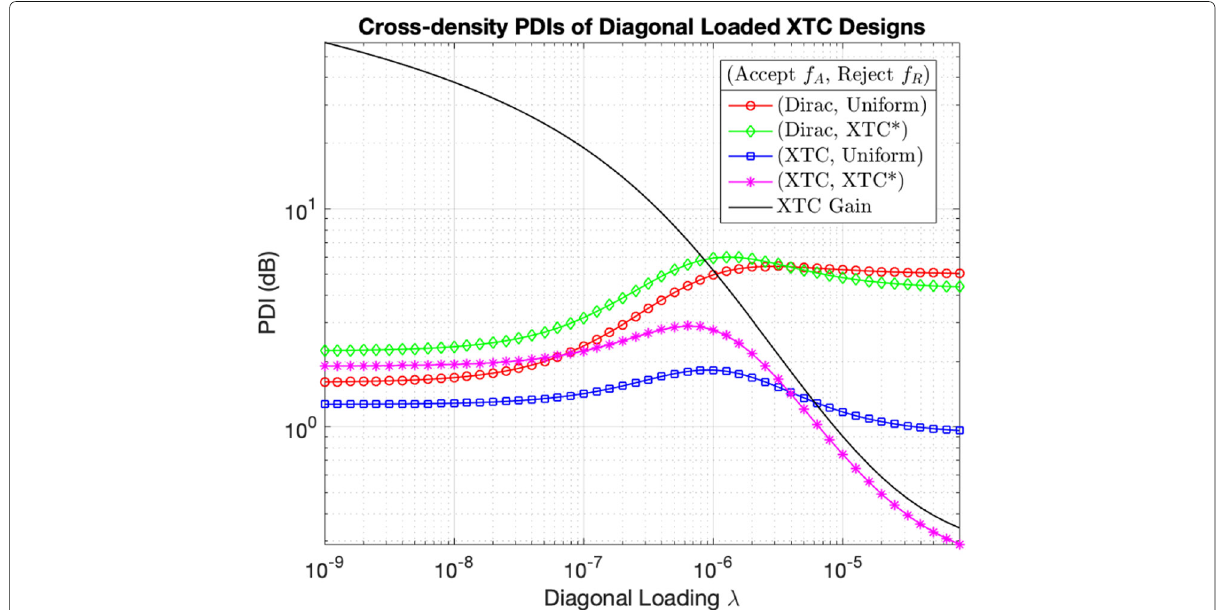
Fig. 6 Constant parameter λ regularized beamformers [7] parameterized by Eq. 47 achieve unbounded XTC gains. Their beampatterns evaluated w.r.t. PDI give the expected XTC gain over different accept and reject density functions